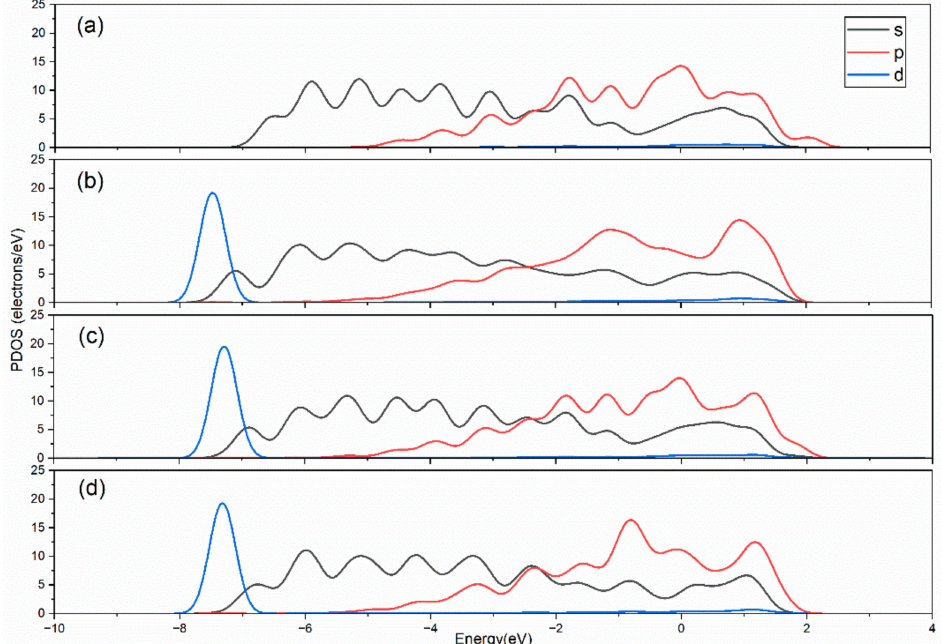
Figure 8. The partial density of states of ( a ) Mg, ( b ) Mg-Al-Zn, ( c ) Mg-Al-Zn*, and ( d ) Mg-Al-Zn**. The potential permitted energy for transitions, such as thermal excitation, can be displayed using a DOS plot. An electron in a valence band is known as an occupied